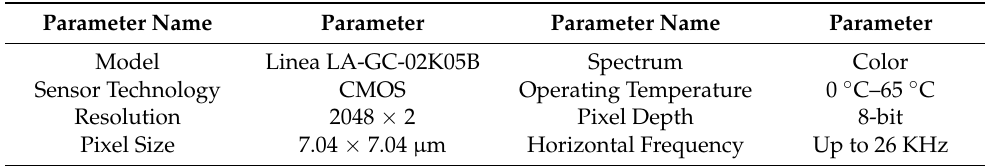
Figure 1. Image acquisition device. 1. Transmission device, 2. Transmission belt, 3. Control panel, 4. CCD camera holder, 5. CCD camera, 6. Sample solid wood flooring, 7. Photoelectric sensor, 8. Pressure wheel. Table 1. Specific parameters of the CCD camera.